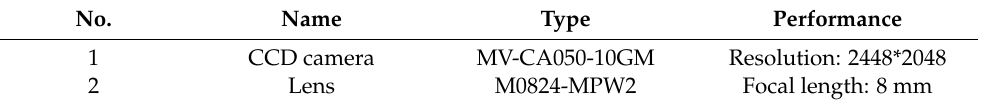
Table 2. Main parameters of the